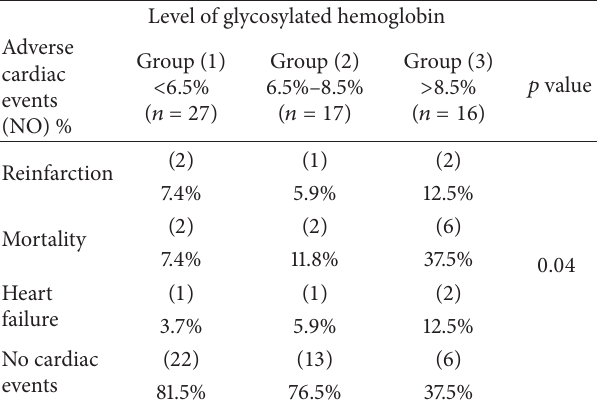
Table 3: Adverse cardiac events in the study groups according to